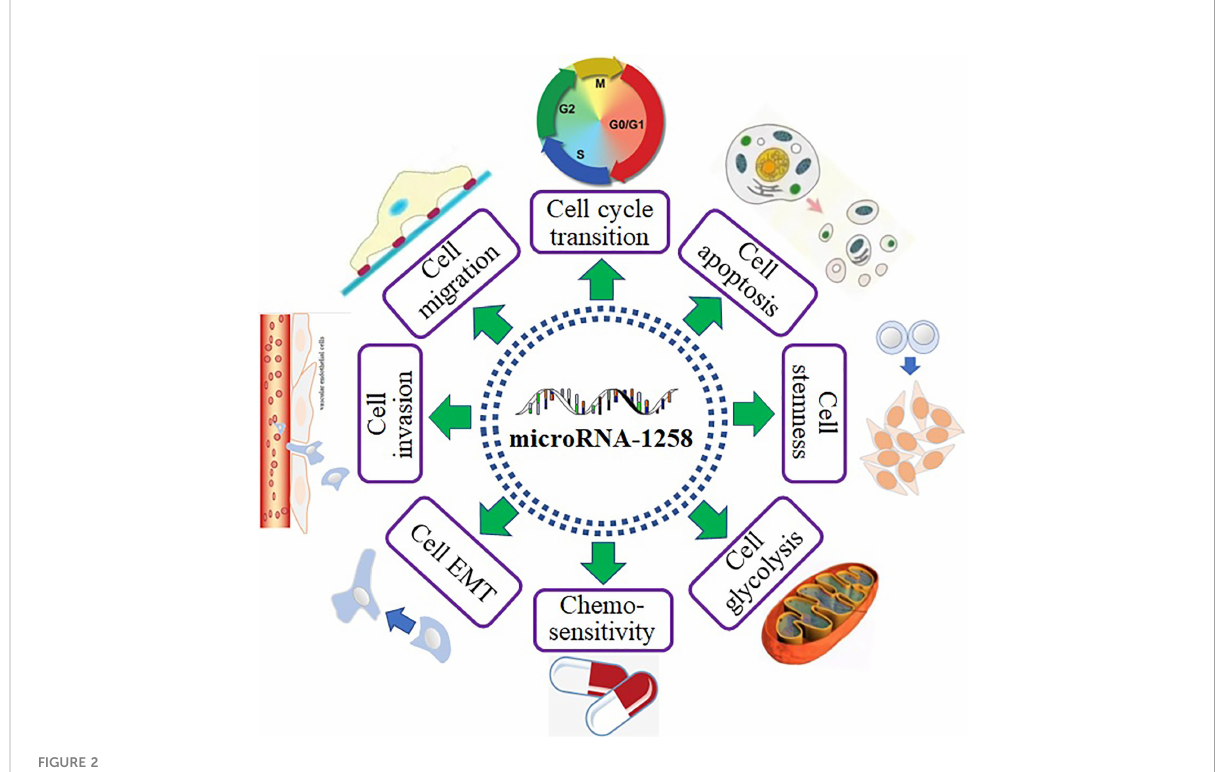
FIGURE 2 The biological functions of miR-1258 in human